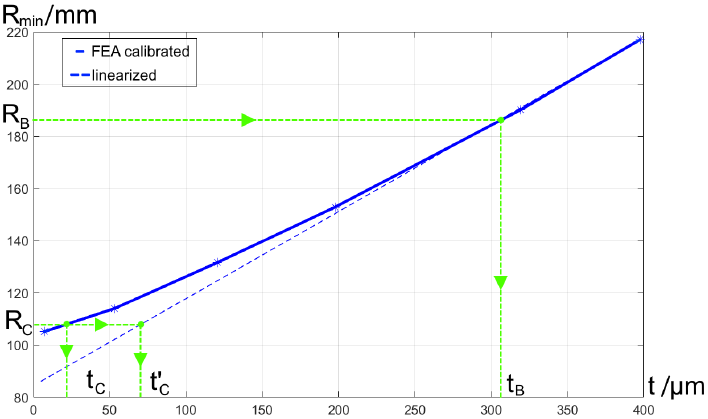
Figure 13. Dependence of the achievable detector radius of curvature on the dye